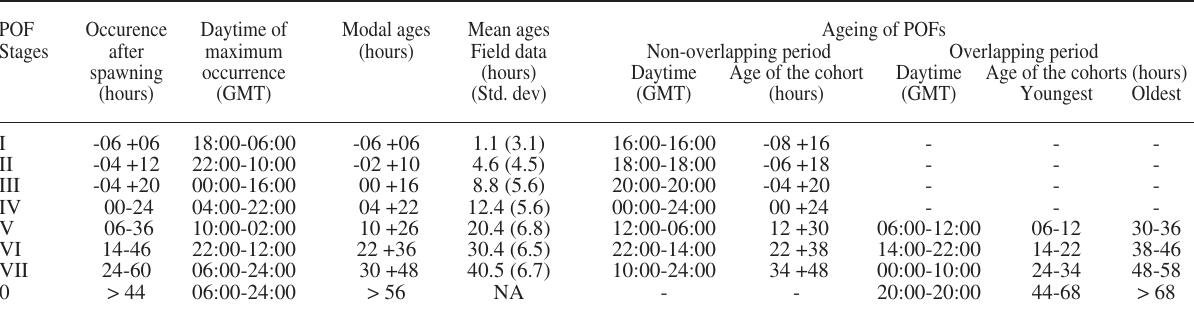
Table 6. – summary of time of occurrence and respective ages of the different PoF stages based on the results obtained from both the captiv- ity experiments and the field-survey samples.